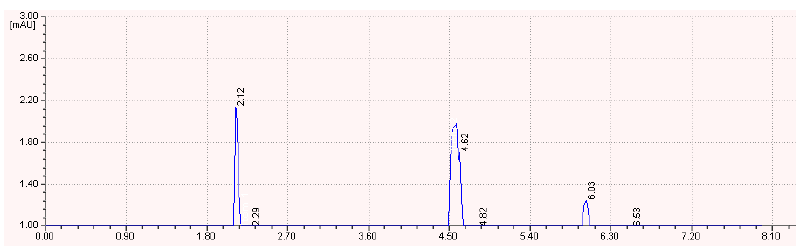
Figure 9. HPLC chromatogram of hydrolyzed biosurfactant from B. subtilis strain Al-Dhabi-130.